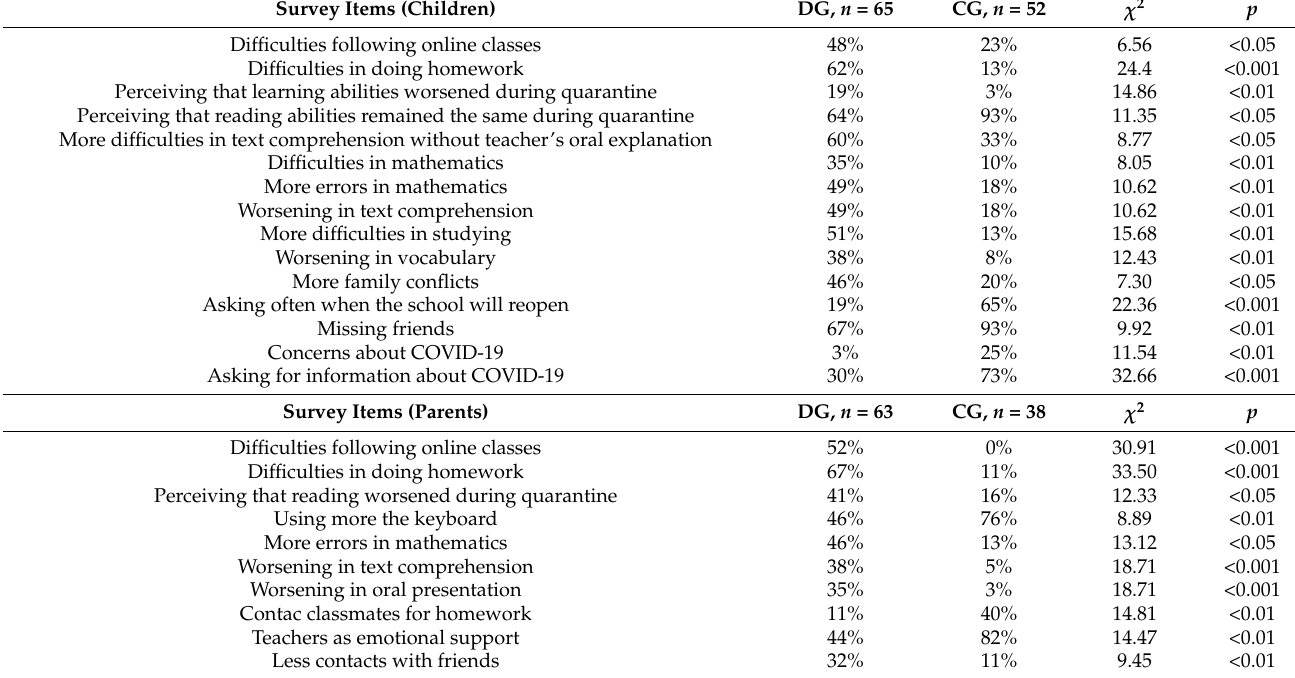
Table 1. Children and parents’ comparison about online school management. Note: DG, dyslexia group; CG, control group. Survey Items